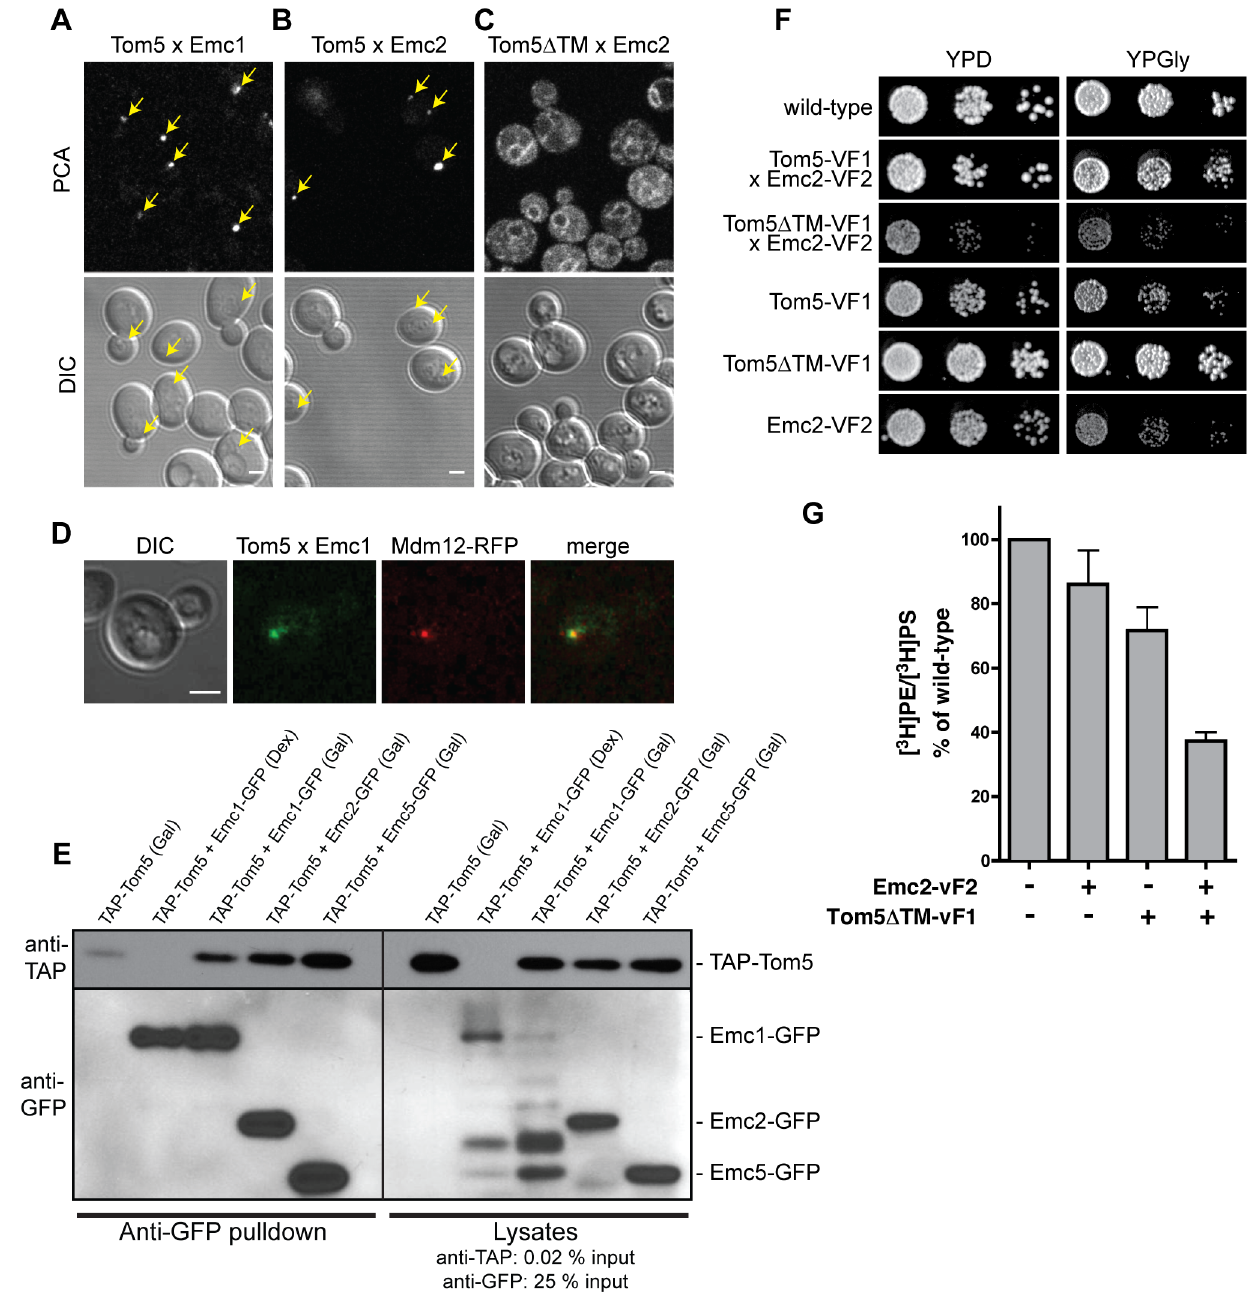
Figure 9. The EMC interacts with Tom5 at ER-mitochondria contacts. (A and B) Interactions between Tom5 and Emc1 (A) and Emc2 (B) proteins imaged by Venus PCA. (C) Interaction between Tom5 D TM and Emc2 by PCA. (D) Colocalization of the Tom5–Emc interaction and Mdm12– RFP of the ERMES complex. (E) Coimmunoprecipitation of TAP–Tom5 and Emc1p, Emc2p, or Emc5p fused to GFP. Expression of TAP–Tom5 was induced in medium containing galactose (Gal) and repressed in medium with glucose (Dex). (F) Yeast growth assays for the indicated strains on media containing glucose (YPD) or glycerol (YPGly). Tom5 6 Emc2 and Tom5 D TM 6 Emc2 indicate haploid strains used for PCA containing Tom5 tagged with VF1 and Emc2 tagged with VF2. (G) Cells with the indicated genotypes were labeled with [ 3 H]serine as in Figure 4A. The ratio of [ 3 H]PS converted to [ 3 H]PE was determined and expressed as a percent of wild-type cells (mean 6 s.d., n =3 independent experiments). * p , 0.05 compared to wild-type, independent two-tailed t test. All scale bars, 2 m m. The data used to generate this graph are in Table